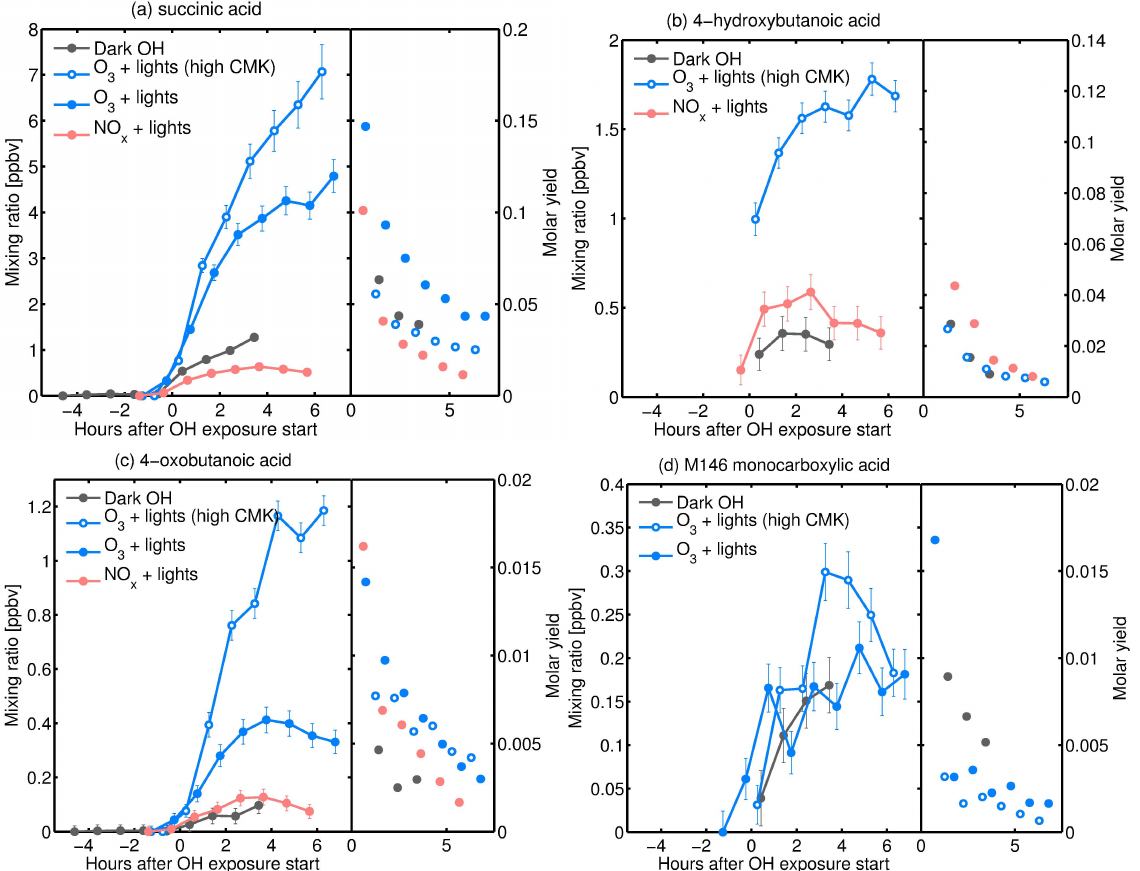
Fig. 7. Mixing ratios (left axis) and molar yields (right axis) of acids observed: (a) succinic acid, (b) 4-hydroxybutanoic acid, (c) 4- oxobutanoic acid, and (d) monocarboxylic acid with molar mass